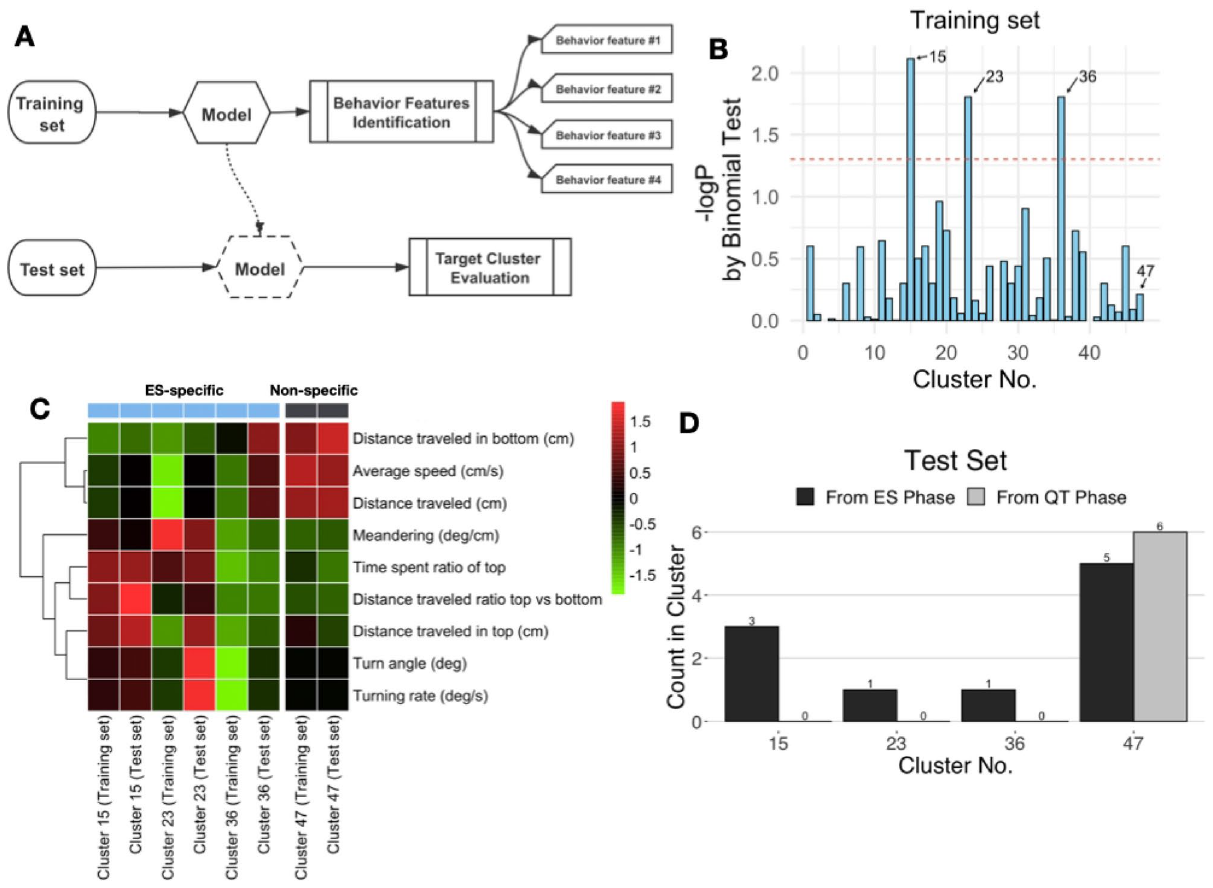
Figure 6. Evaluation of the behavior features newly identified by machine learning. ( A ) Fit model was trained on the training set data, and the new treatment-specific behavior feature was identified. The test set was used to evaluate the behavior feature newly defined on the training set. ( B ) ES-specific behavior feature screening in the training set. Cluster nos. 15, 23, and 36 were significantly associated with the treatment (ES-specific); cluster no. 47 was not significantly associated with the ES treatment (nonspecific). The cluster identifier number is shown on the x-axis, and -log p-values are indicated on the y-axis. The horizontal red dashed line shows a p-value of 0.05 by the binomial test (the probability of correlation was not significantly different from 50% for each of the clusters). ( C ) Hierarchical clustering revealed the similarity among cluster nos. 15, 23, 36 (ES-specific) and 47 (nonspecific) according to the overall behavioral profiles from the training set and test set. ( D ) Representative graph shows the counts of clusters 15, 23, and 36 (ES-specific) from the ES and QT